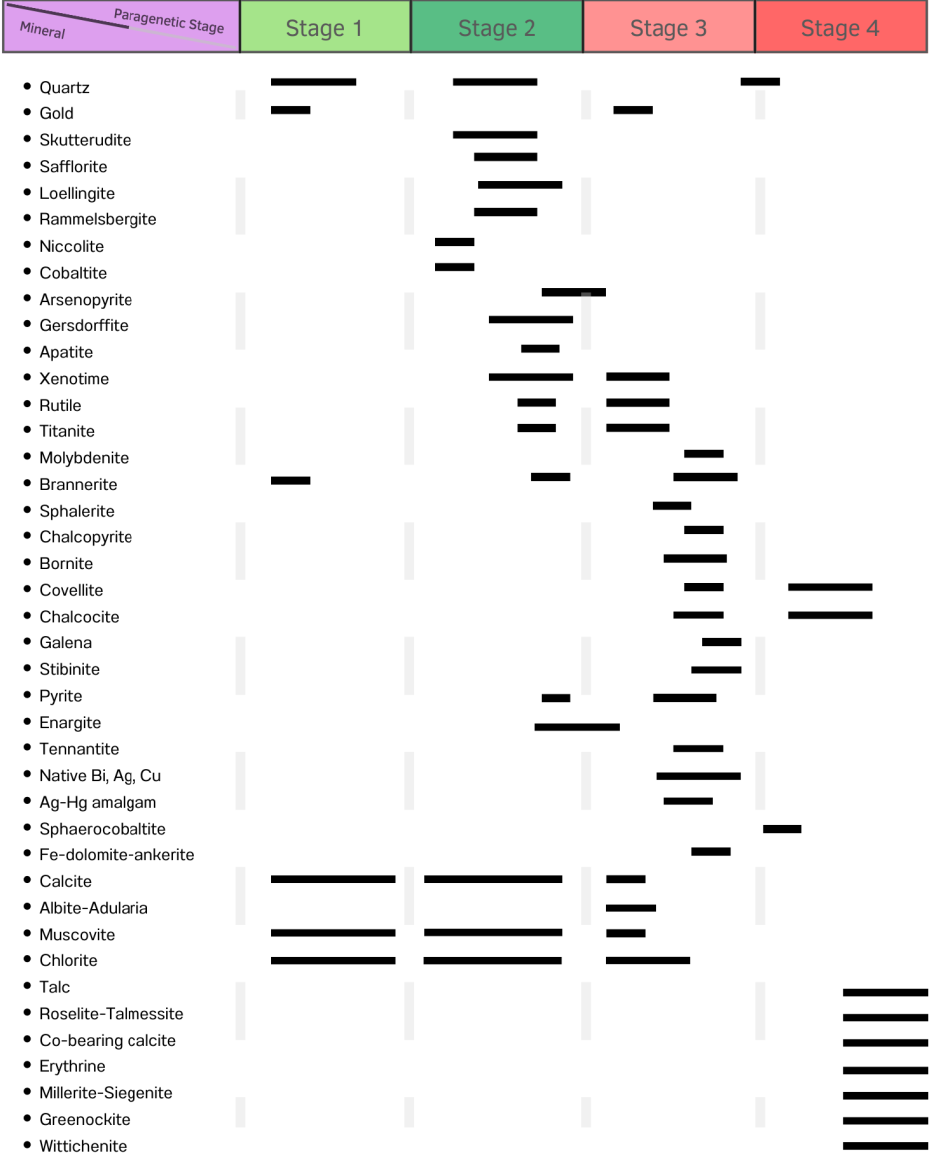
Figure 5. Polymetallic Bou Azzer district paragenetic sequence modified from [48].